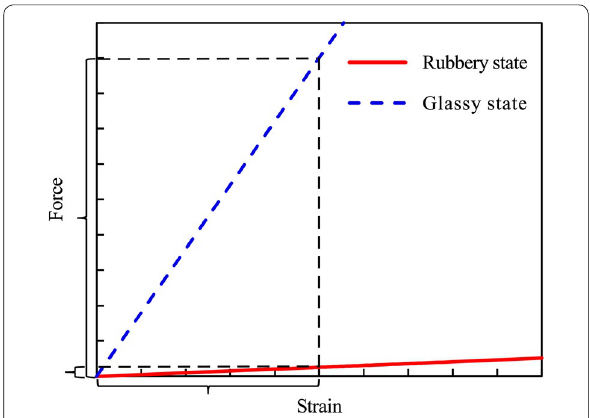
Fig. 1 Relationship between applied force and strain on cantilever fixed SMP sheet. As the elastic modulus of the SMP can be changed according to the temperature, the relationship between the strain and the applied force can also be